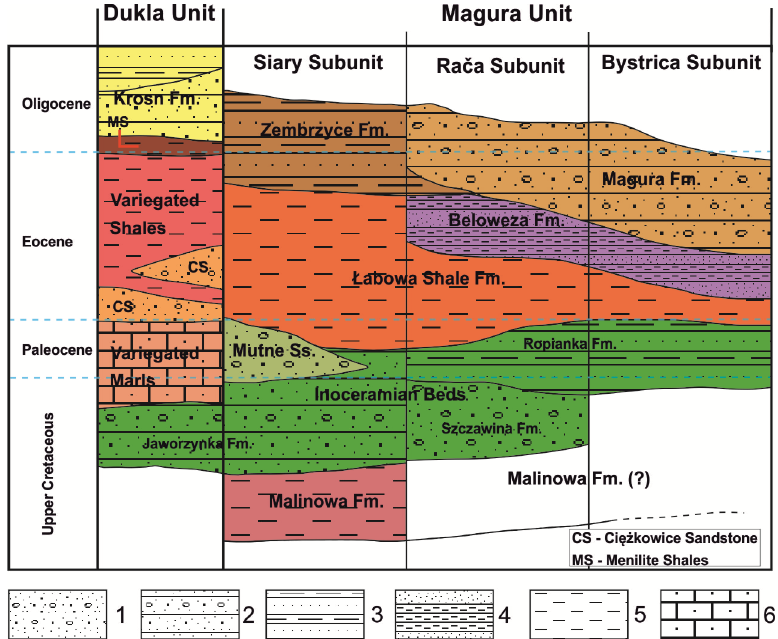
Figure 2. Simplified lithostratigraphic scheme of the Magura and Fore-Magura Units. 1—mainly thick-bedded sandstones and conglomerates, 2—thick-bedded sandstones, subordinately conglom- erates, interbedded by thin shales, 3—thick to medium bedded sandstones and shales, 4—shales and thin to medium bedded sandstones, 5—shales, subordinately thin-bedded sandstones, 6—marls (modified after [70]).